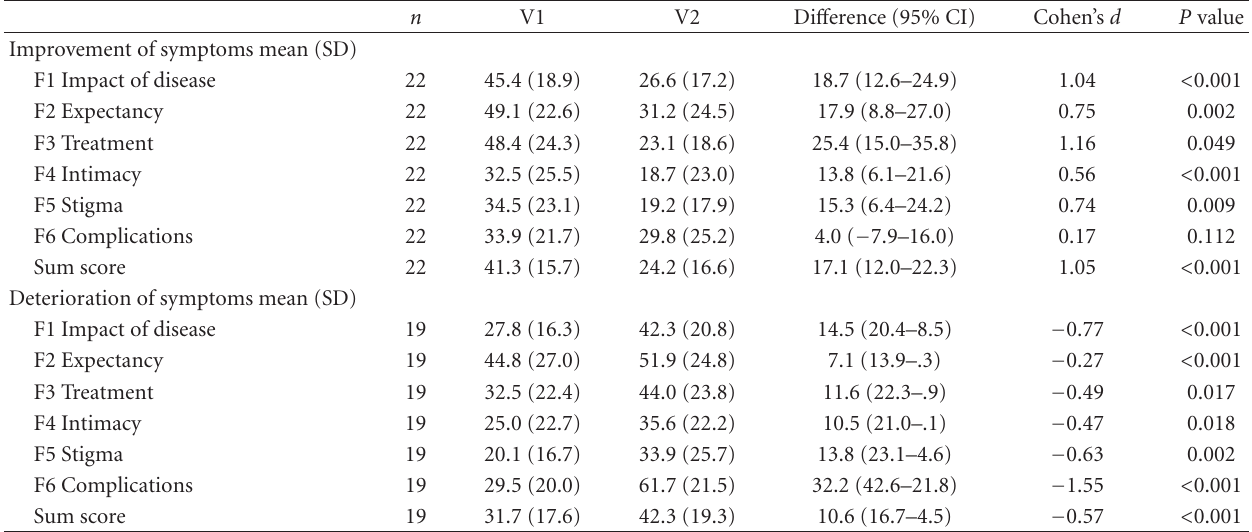
Table 6: Comparison of scores at V1 and V2 in patients reporting improvement or deterioration of IBD symptoms. E ff ect-size calculated with Cohen’s d